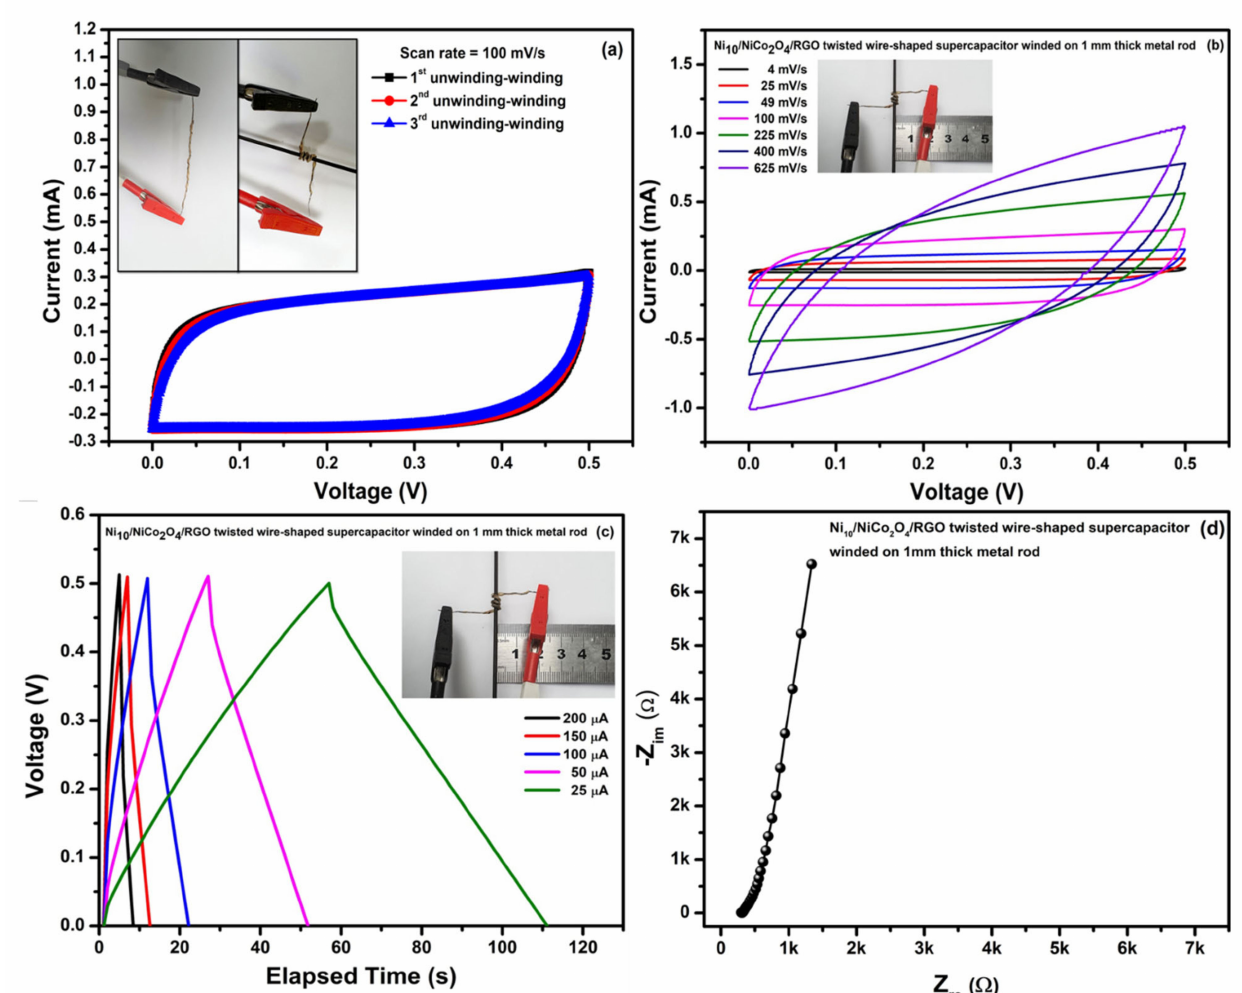
Figure 14. ( a ) CV curves relating to unwinding-winding sequences of Ni 10 /NCO/RGO twisted WSC at 100 mV/s scan rate, ( b ) CV curves for WSC in winded state at various scan rates, ( c ) GCD curves for WSC in winded state at different applied currents, and ( d ) EIS study (Nyquist plot) for WSC in winded state at 100 kHz–0.01 Hz under 0.01